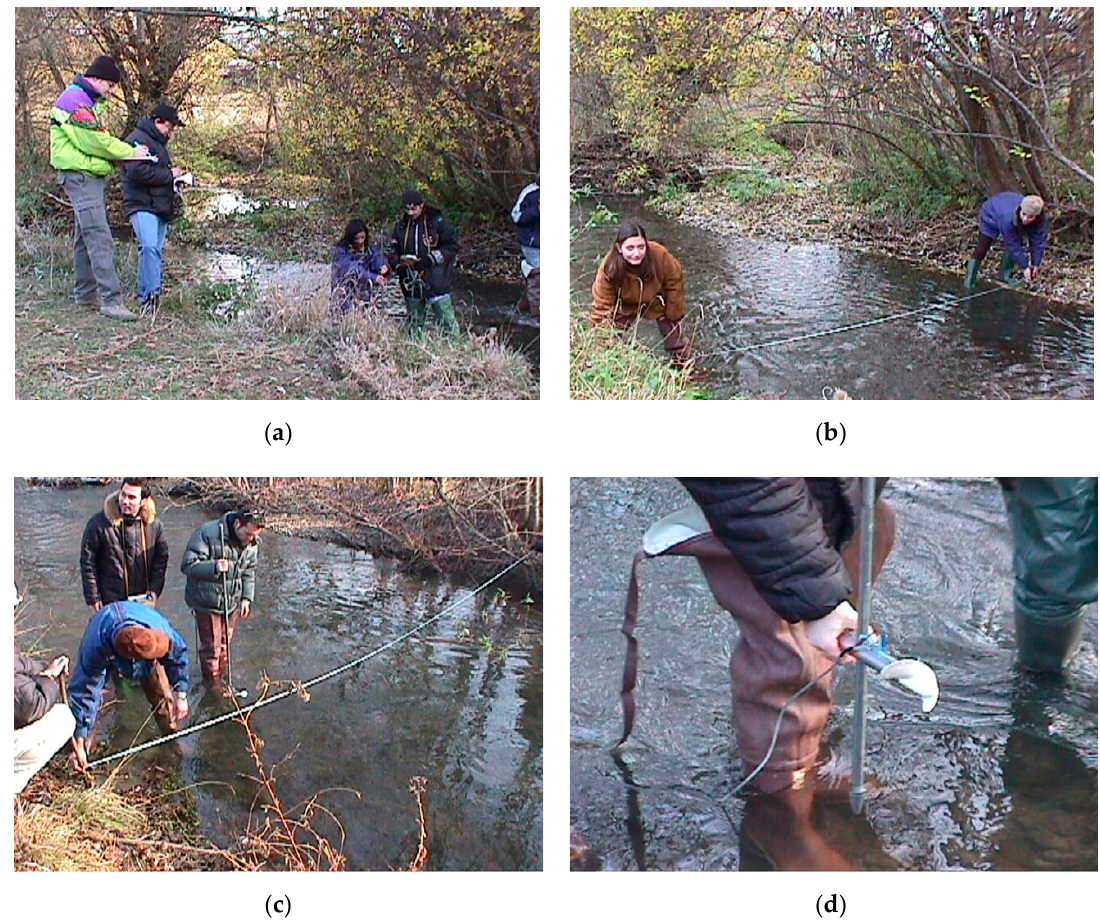
Figure 1. Traditional practical lesson in the field: ( a ) selection and demarcation of the cross-section; ( b ) measurement of width with graduated tape; ( c ) detection of different verticals for the velocity acquisition, and ( d ) placing of the current meter at the desired location.